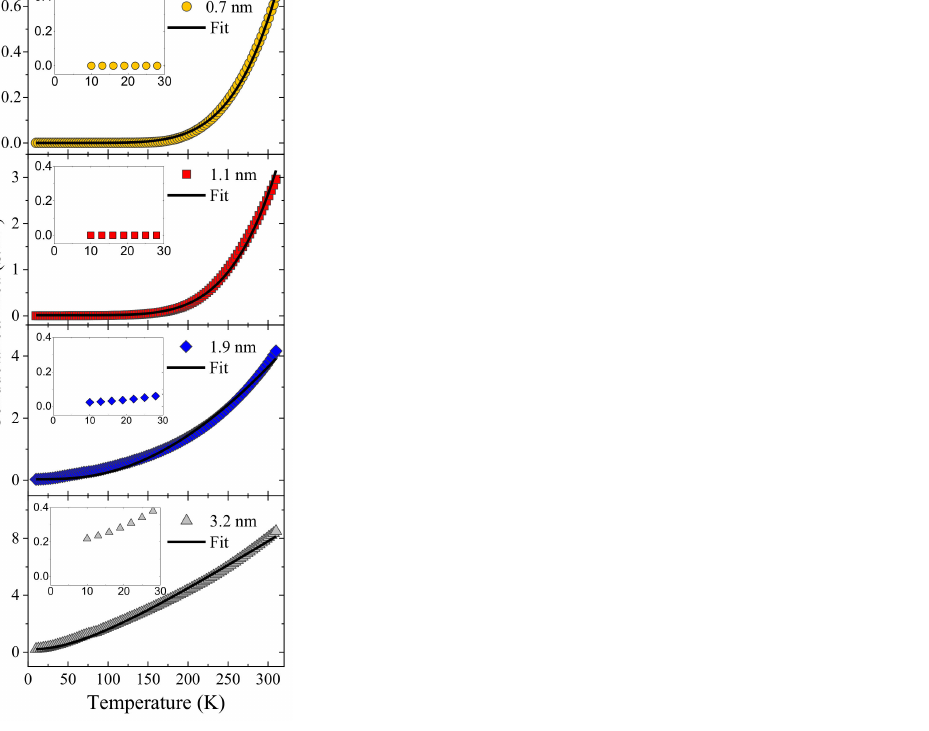
Figure 4. Conductance as a function of temperature and wall thickness of LC-CNTs. Insets show a zoom near 10 K. Table 1. Fitting parameters for the experimental conductance of Figure